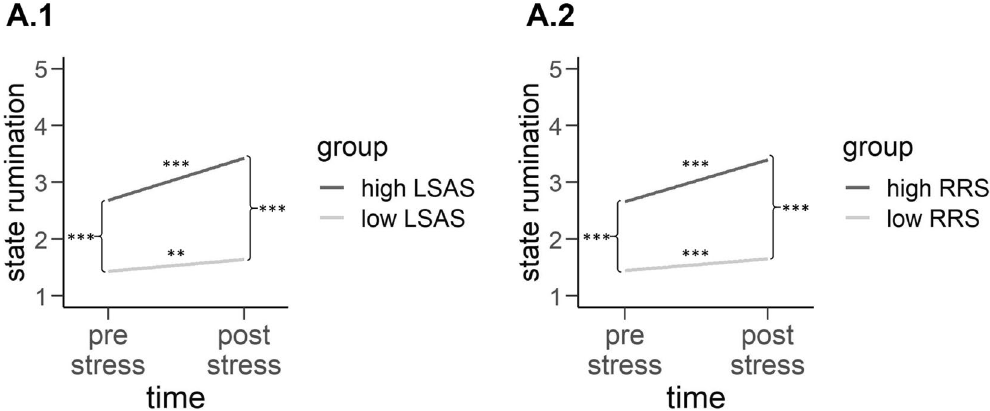
Figure 2. Predicted state rumination dependent on time (pre-stress vs. post-stress) according to the regression model including LSAS ( A.1 ) and RRS ( A.2 ), respectively. The significant interaction effects of LSAS and time ( A.1 ) and RRS and time ( A.2 ) have been categorized into low and high total scores (± 1 SD) for reasons of clearer visualization. ** p < 0.01; *** p <